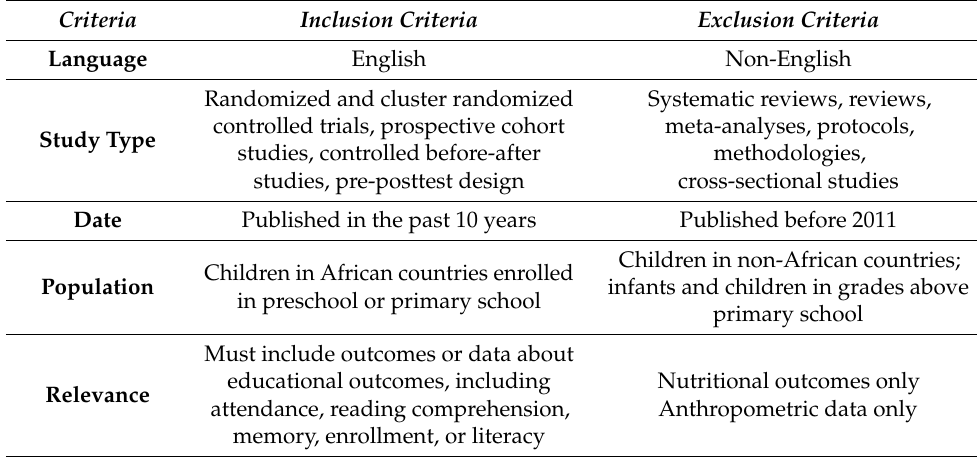
Table 1. Criteria for article inclusion and